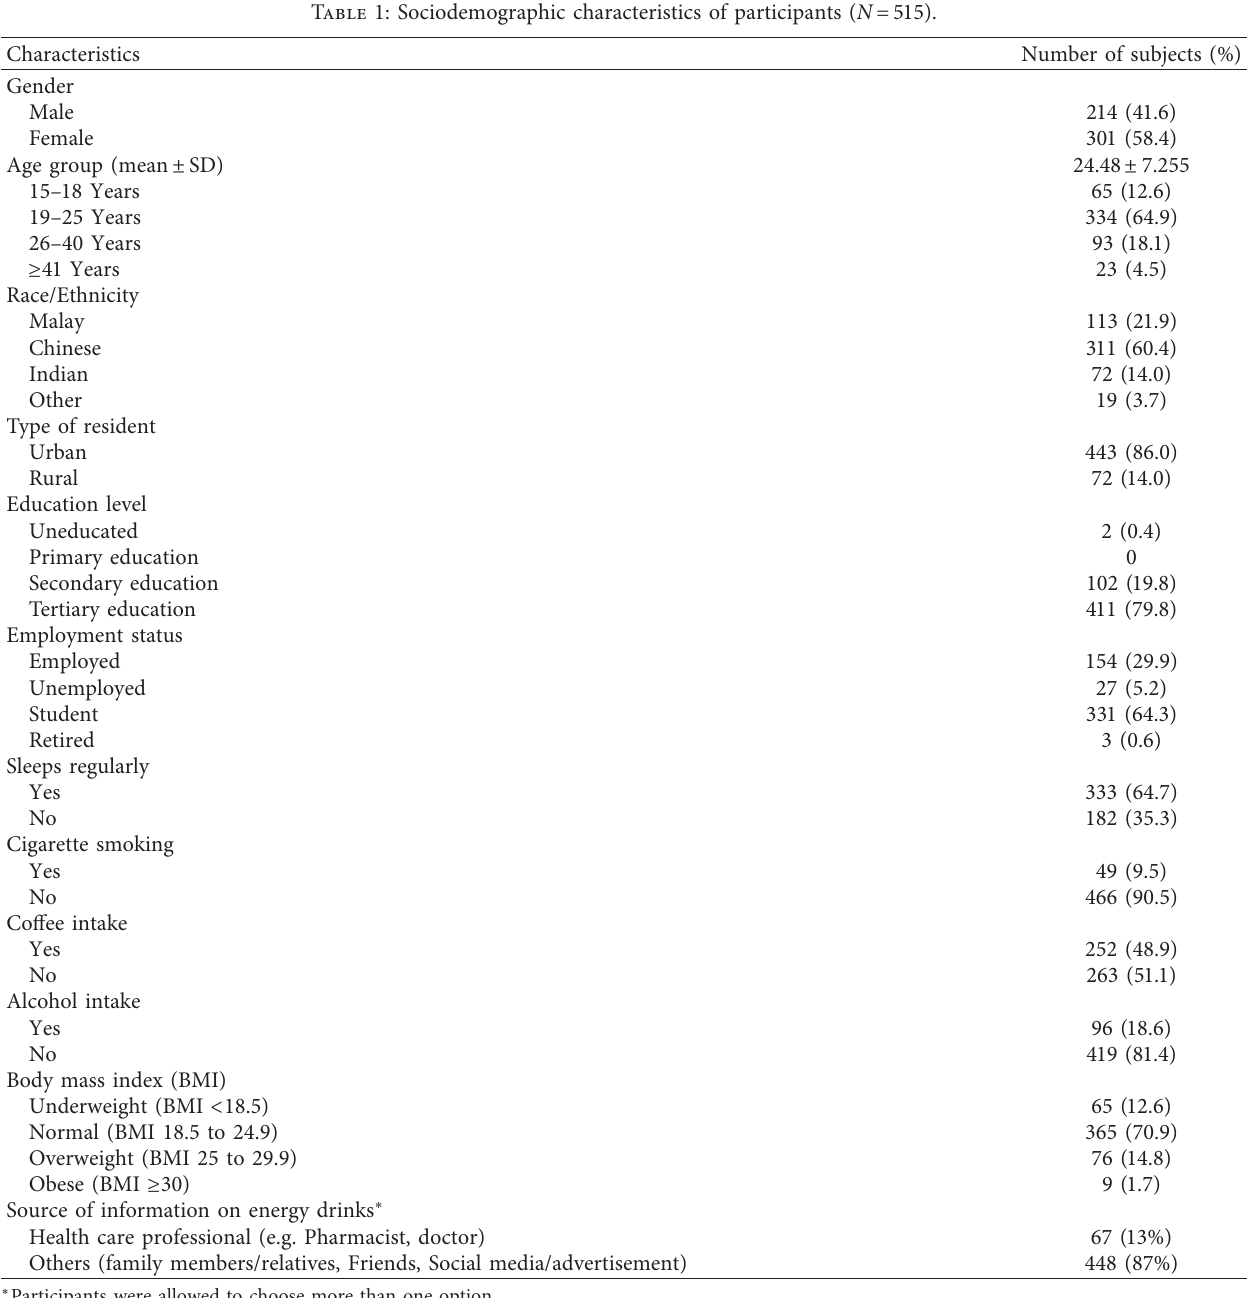
Table 1: Sociodemographic characteristics of participants ( N �